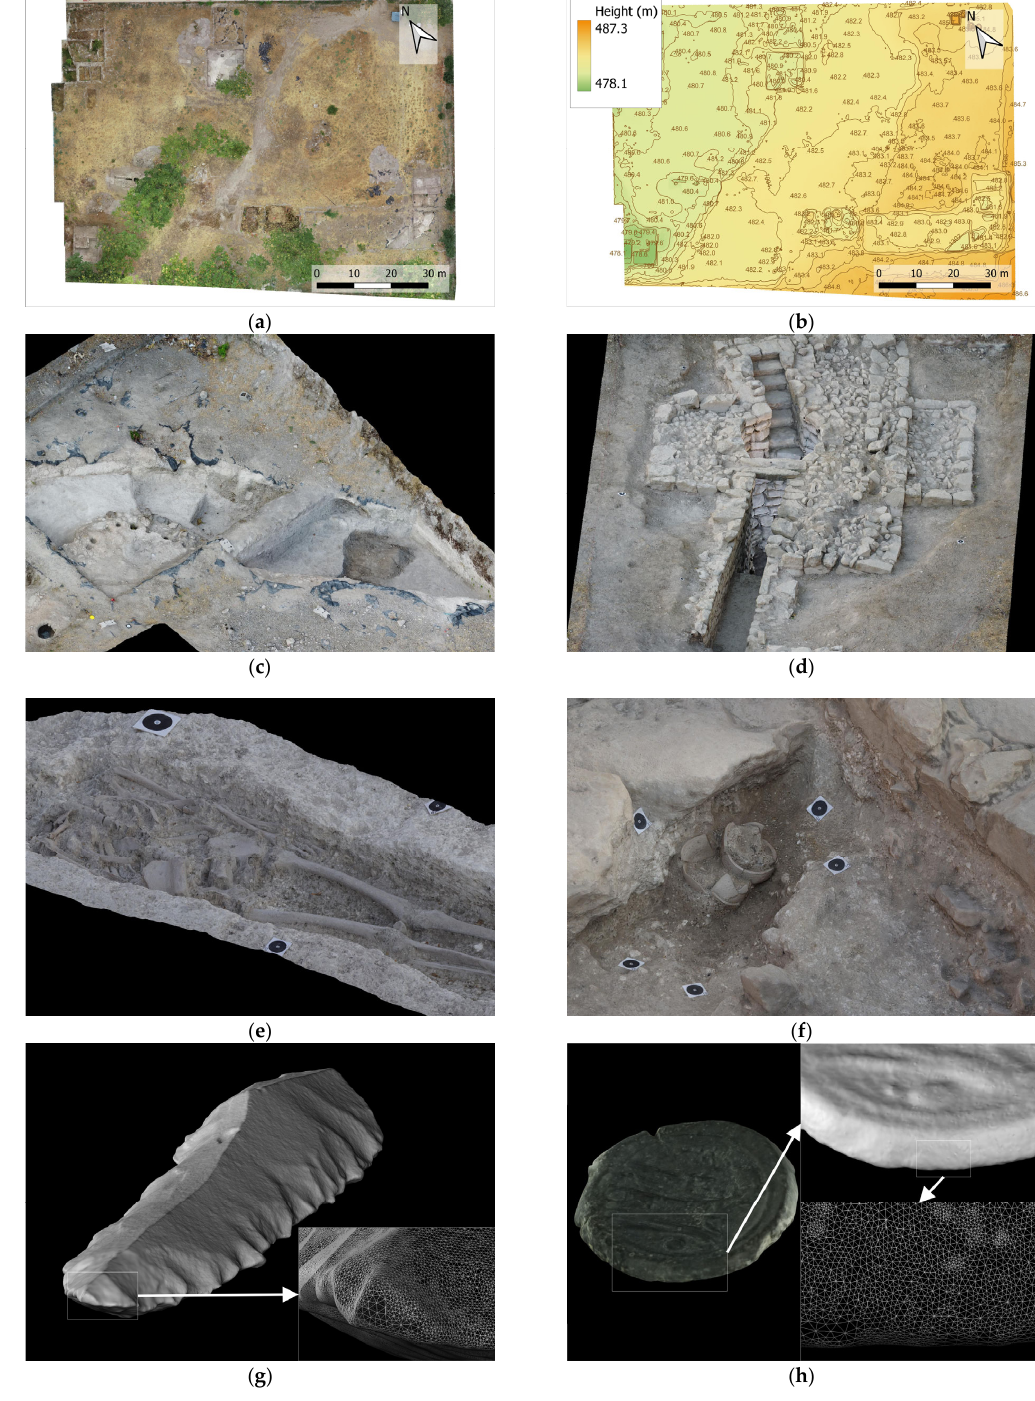
Figure 5. Examples of results obtained in this study: ( a ) orthoimage of the complete area (SL1–S1); ( b ) topographic map of the complete area (SL1–S1); ( c ) 3D model of the chalcolithic ditch (SL2–S2); ( d ) 3D model of a Roman well (SL2–S4); ( e ) 3D model of a Visigoth burial (SL3–S3); ( f ) 3D model of an Iberian burial (SL3–S3); ( g ) 3D model (structured ‐ light scanning) of a silex tool and detail of the wireframe mesh (SL4–S4); ( h ) 3D model of a roman coin (SL4–S4) and detailed views without texture and showing the wireframe.